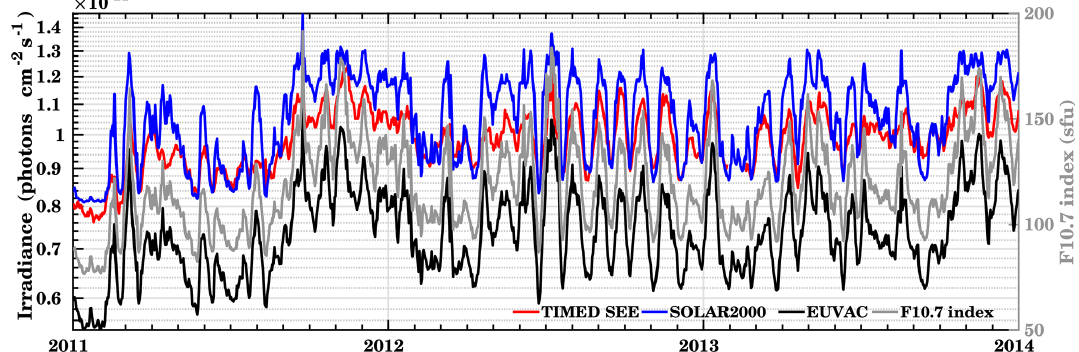
Figure 2. Time series of 0.5 to 105nm integrated daily irradiance from 2011 to 2013 estimated from TIMED SEE observations, SOLAR2000, and EUVAC. The right y axis represents the F10.7